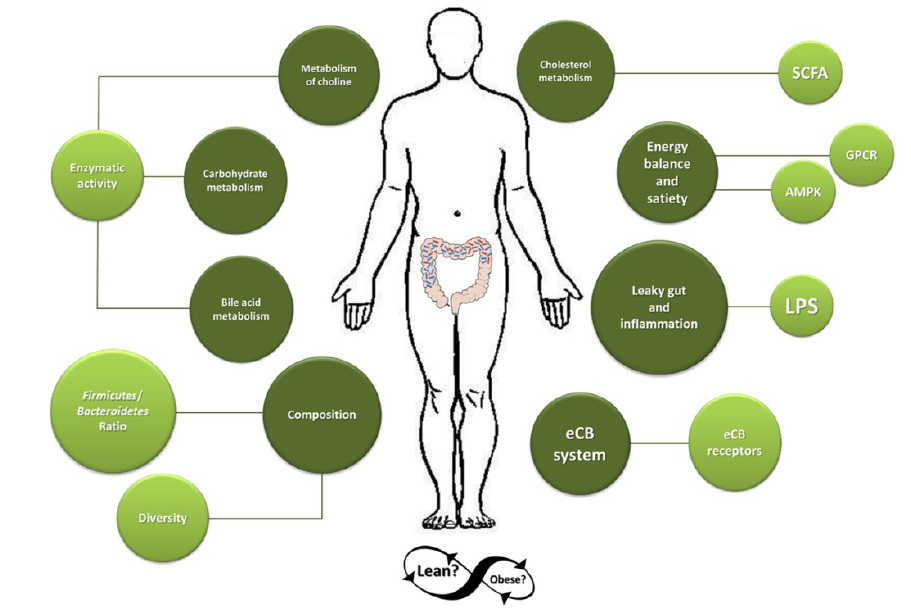
Figure 1. The gut microbiota may lead to obesity by disturbing host